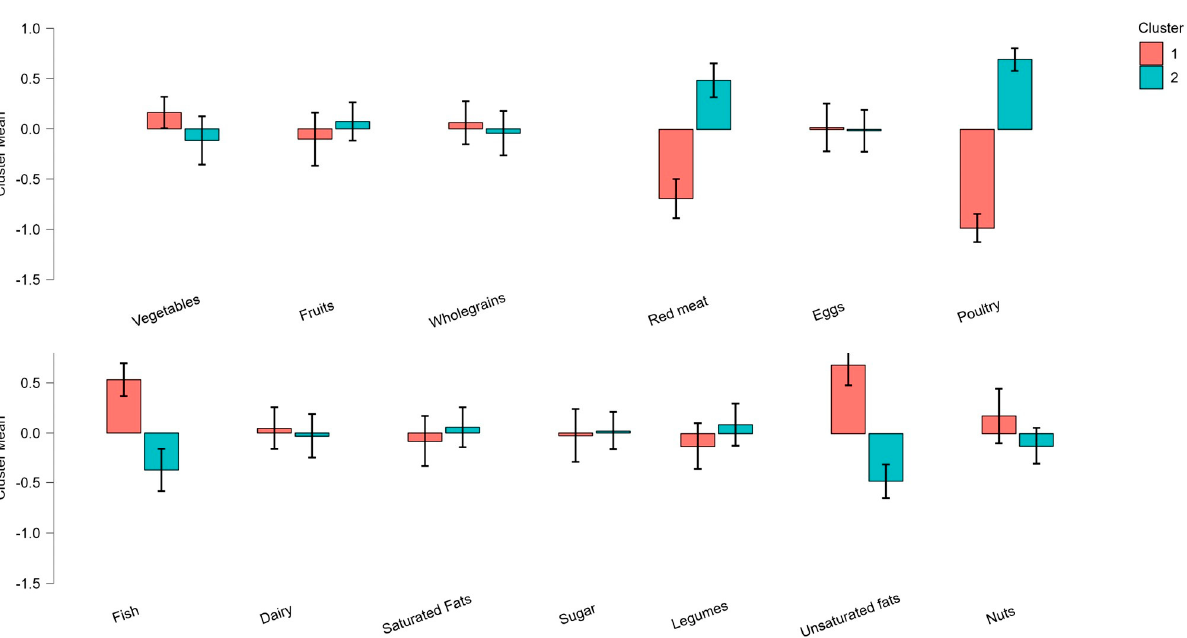
Figure 2. Cluster means for each WISH dietary component. Data are standardised means (95% CI). Those in cluster 2 were also more likely to be female (X 2 (1,111) = 8.738, p < 0.003) and to consume fewer calories ( F (1, 109) = 3.992, p < 0.048, η 2 = 0.036). Those in cluster 1 tended to consume more alcohol ( F (1, 109) = 3.772, p = 0.055, η 2 = 0.034). Clusters did not differ regarding physical activity ( F (1, 109) = 2.726, p = 0.102, η 2 = 0.025) or BMI ( F (1, 109) = 0.136, p = 0.713, η 2 = 0.001) (Table 1). Table 1. WISH dietary components contributing to each cluster.